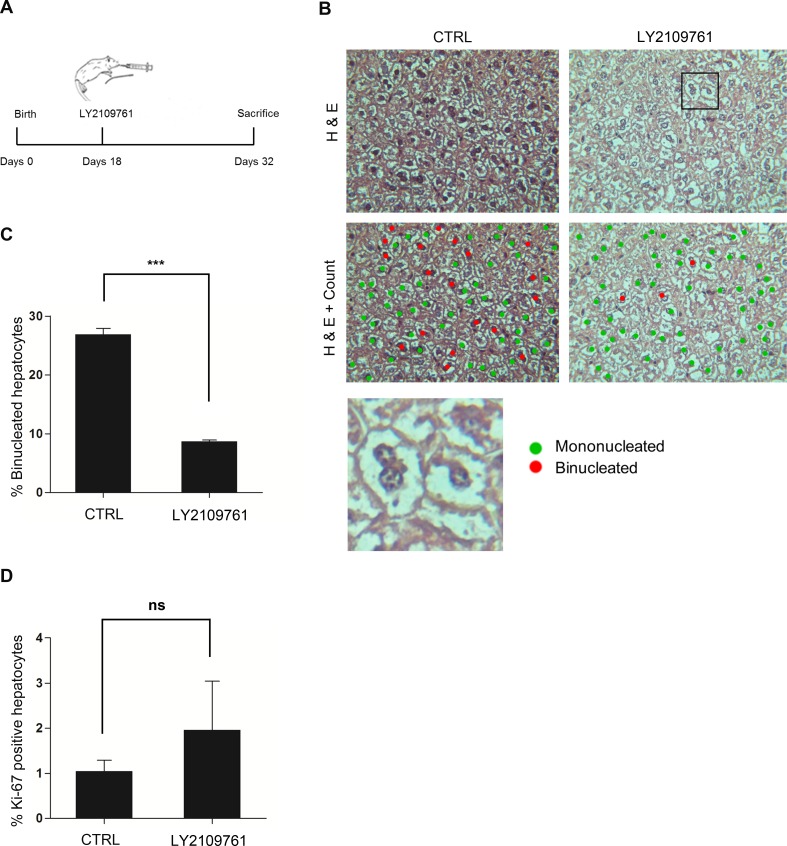
The in vivo inhibition of TGFbeta receptor hampers hepatocyte binucleation.(A) Experimental schedule for in vivo TGFbetaRI/II inhibitor (LY2109761) administration. (B) H&E of liver tissue from LY2109761-treated and control animals. In the lower panels are shown micrographs where binucleated and mononucleated cells are marked in red and green, respectively. A magnification of cells from the upper right panel was shown. (C) Percentage of binucleated cells of LY2109761-treated and control livers. Data are expressed as average values of counts of at least ten slices for each of four mice ± s.e.m. (number of counted cells: >1000 for each mouse). (***p value < 0.001). (D) Percentage of Ki-67 positive hepatocytes, analyzed by immunofluorescence on liver slices from LY2109761-treated and control mice. Data are expressed as average values of counts of at least five slices for each of four mice ± s.e.m. (number of counted cells: >400 for each mouse). (n.s. = not significant p value).